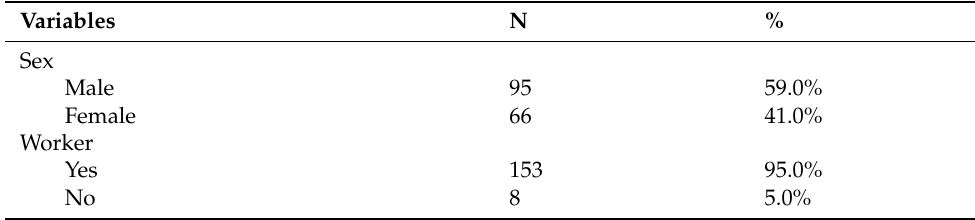
Table 1. Socio-demographic characteristics of the